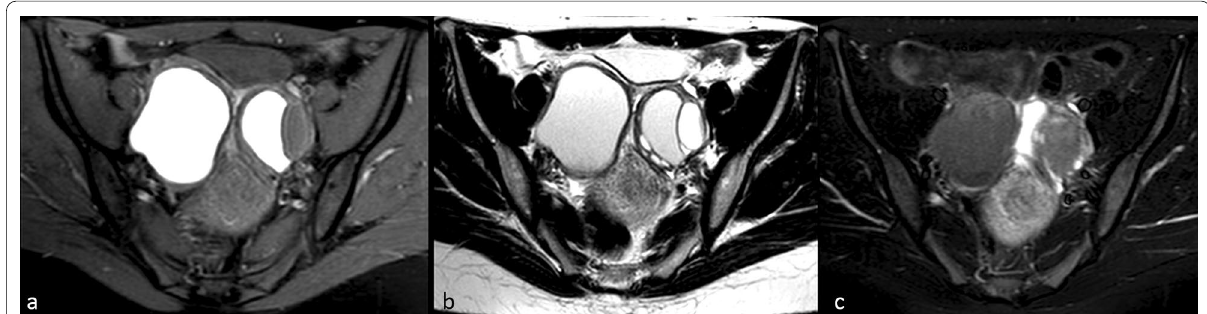
Fig. 13 32-year-old woman with chronic pelvic pain. Axial T1-w. fat-saturated scan ( a ) of the pelvis shows two large hyperintense endometrial